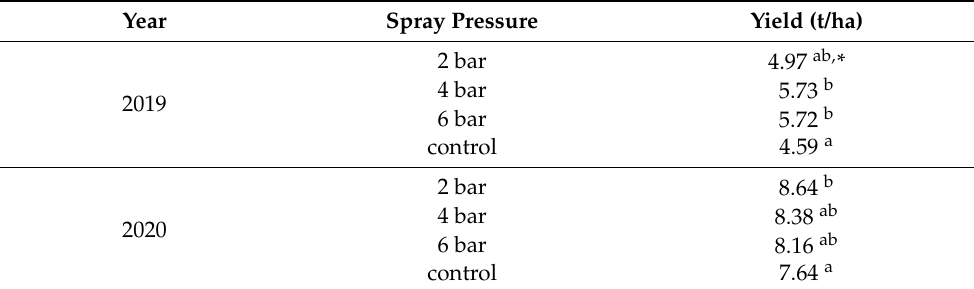
Table 4. Grain yield at 14%